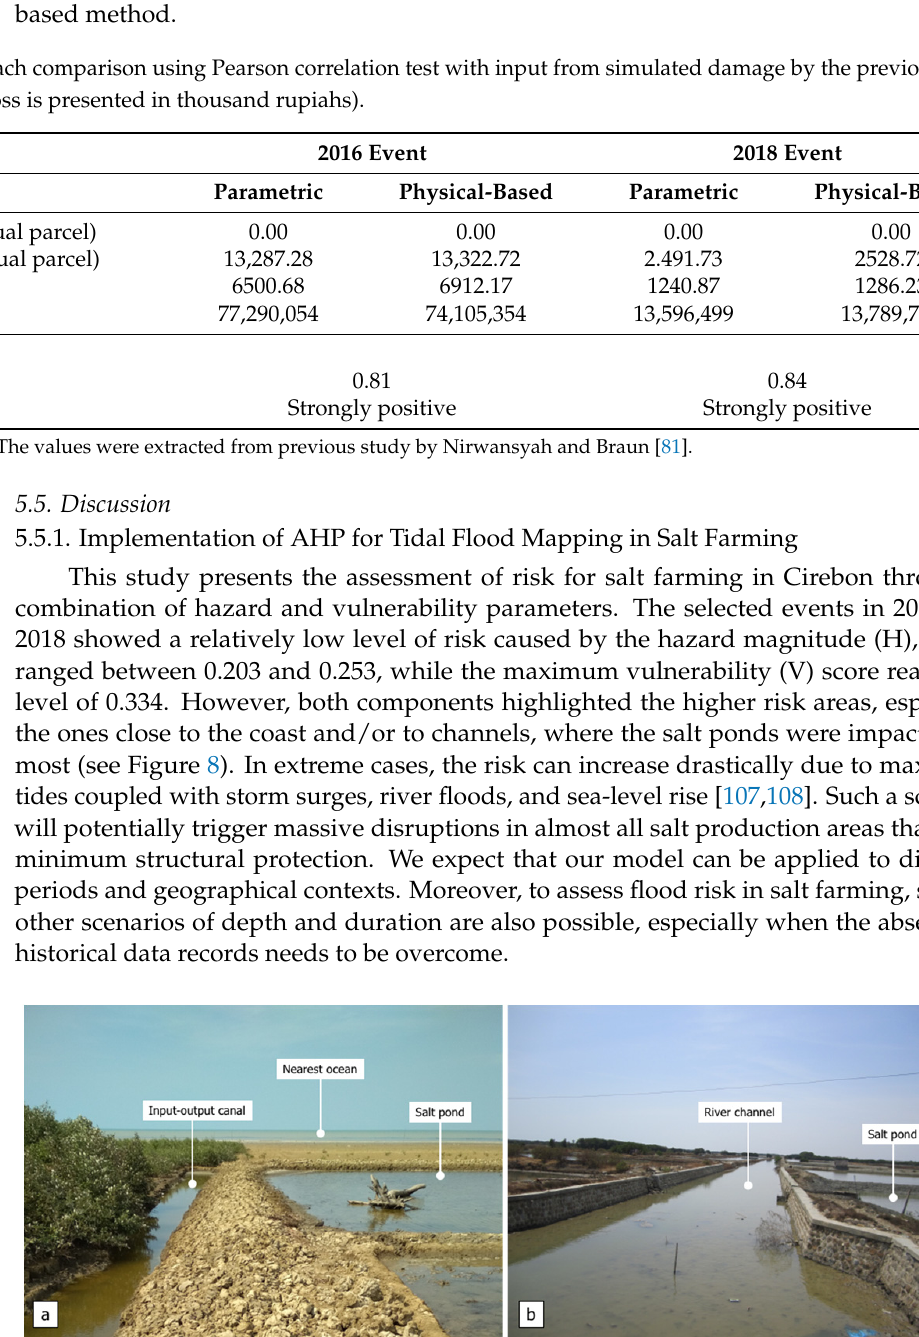
Table 4. Parametric approach comparison using Pearson correlation test with input from simu- lated damage by the previous physical-based model * (loss is presented in thousand rupiahs).